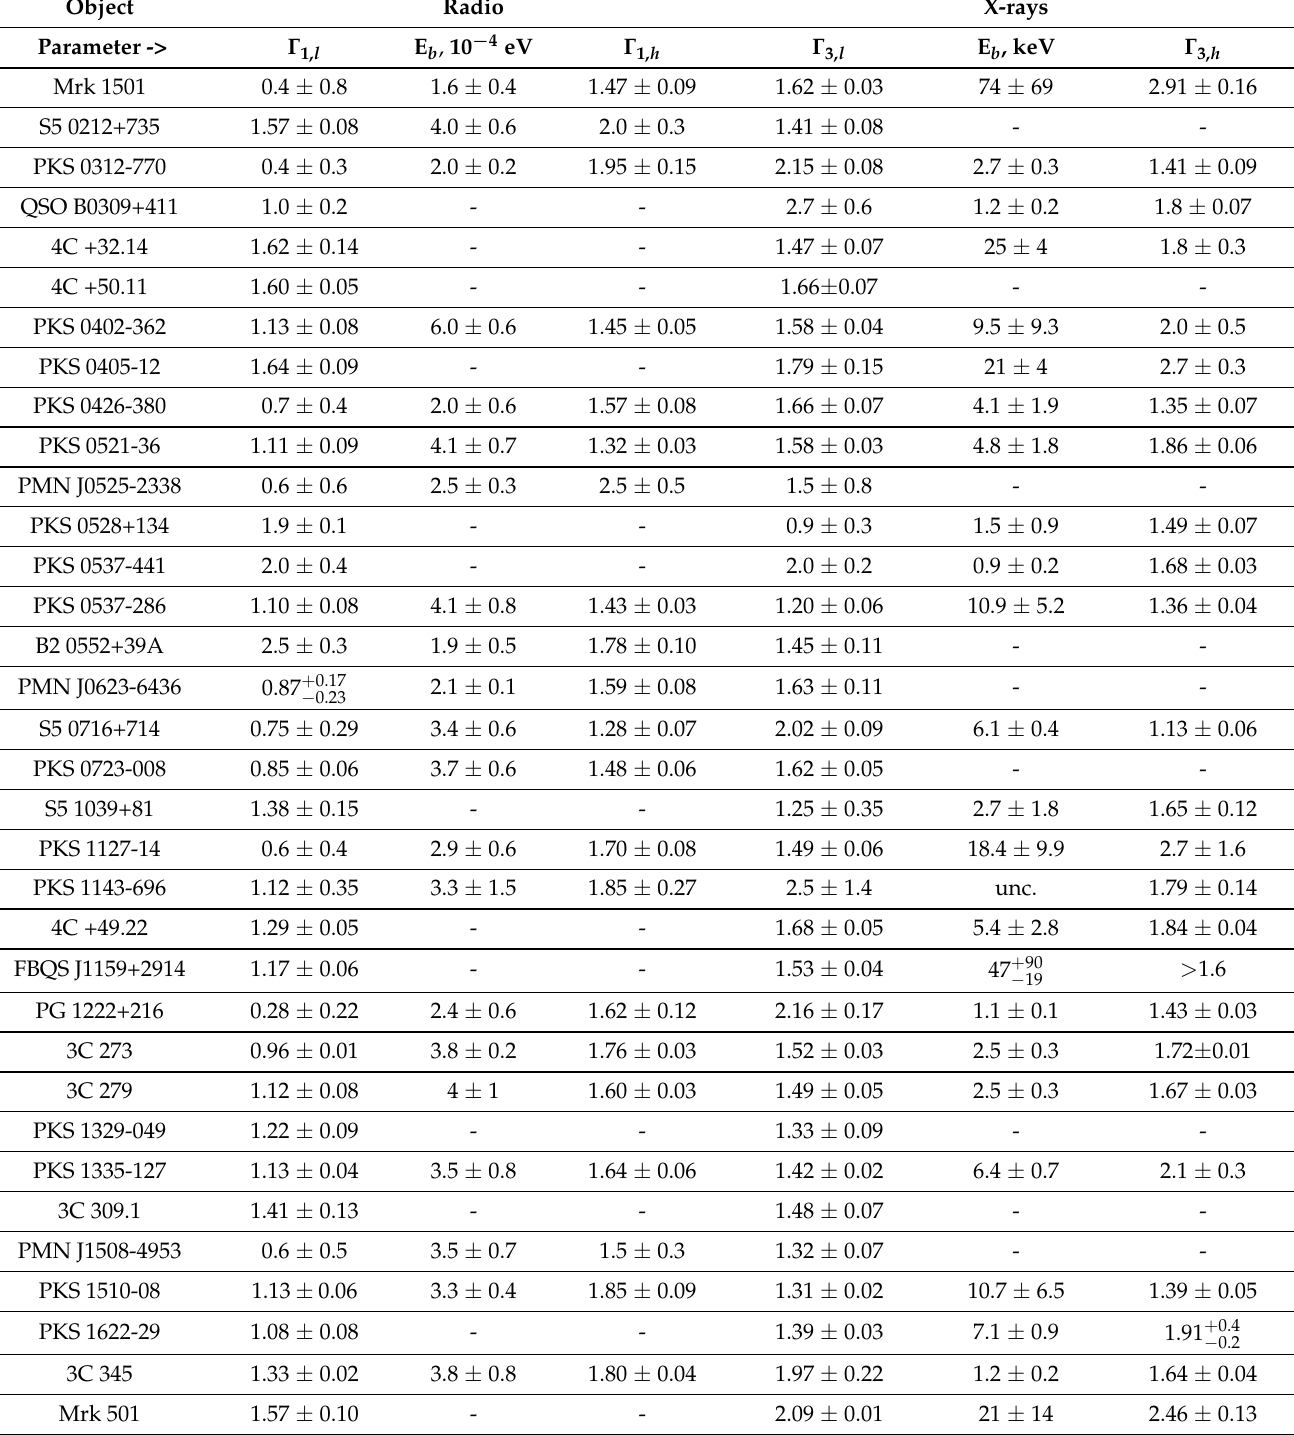
Table 4. The best-fit model parameters for the Planck and Swift/XRT+BAT